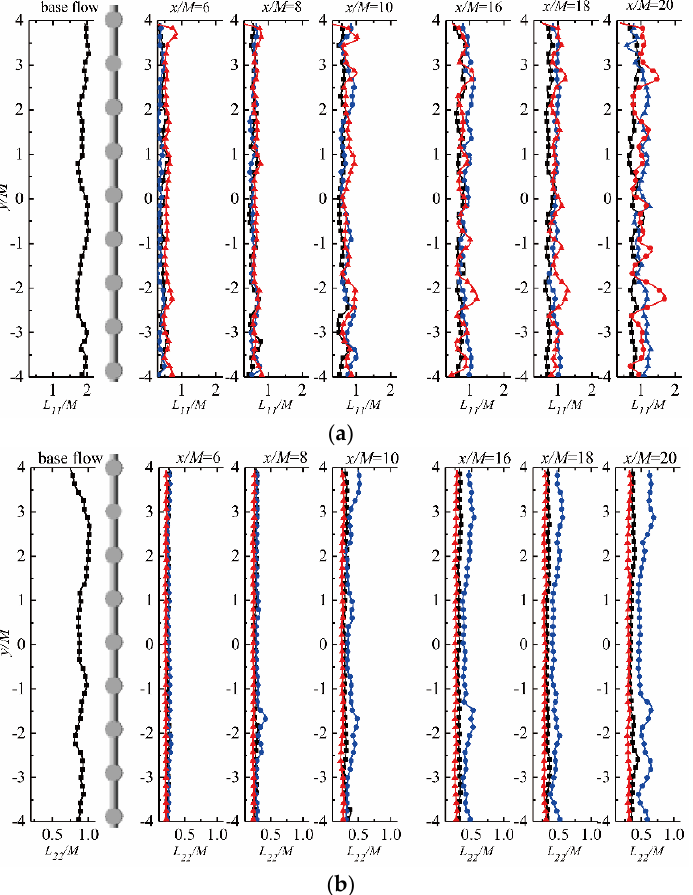
Figure 10. Horizontal distribution of length scales ( a ) longitudinal components ( L 11 / M ); ( b ) lateral components ( L 22 / M ); red (1/3 depth), black (mid-depth), blue (2/3 depth).